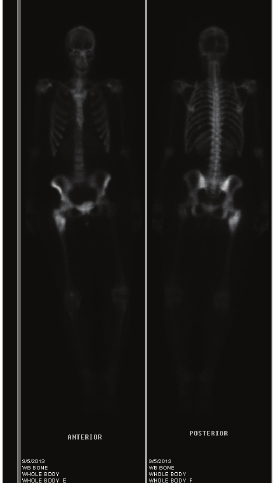
Figure 7: Whole body bone scan utilizing Tc-99 m MDP reveals a discrete area of increased radiotracer uptake within the metaphysis of the right proximal femur. No additional areas of abnormal radiotracer uptake are